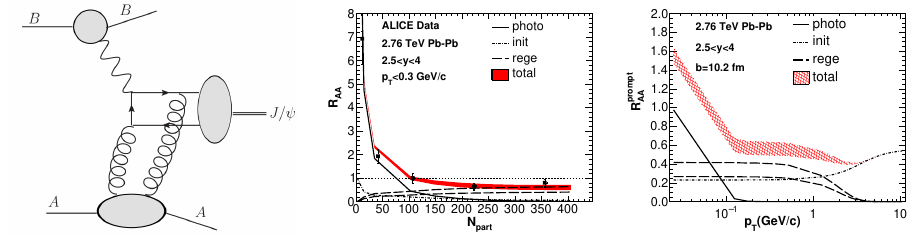
Figure 5. (Color online) Left panel is the schematic figure for photoproduction. The middle panel is J /ψ inclusive R AA as a function of N p in the extremely low p T at 2.76 TeV Pb-Pb collisions. The right panel is the prompt R AA as a function of p T . These figures are cited from [12,